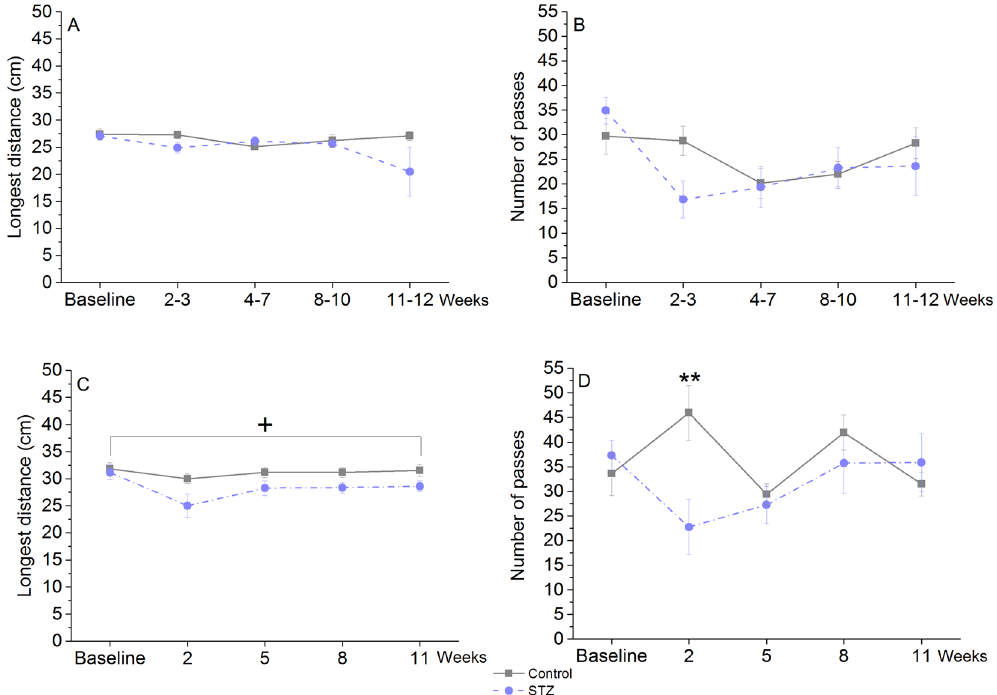
Figure 4. Performance of icv. STZ-injected (‘STZ’) and vehicle-treated (‘control’) rats in the pot jumping task at various time points post-injection. Means ± SEM of number of passes and longest distance jumped over are shown. ( A , B ) Results of old animals. ( C , D ) Results of young animals. **: p < 0.01 significant difference between groups on the same day (post-hoc Duncan test following repeated measures ANOVA with significant Day × treatment interaction: F(4,88) = 5.20, p = 0.000. + : p = 0.047 significant treatment effect in longest distance (F(1, 22) = 4.42). Group size of old STZ-treated rats: n = 11 at Week 2–3, 4–7 and 8–10, n = 8 at Week 11–12.